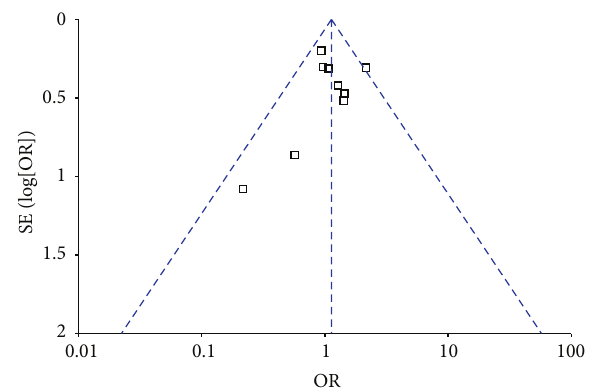
Figure 4: Funnel plots of IL-1 𝛽 -511C/T polymorphism and asthma risk for publication bias. (CC versus